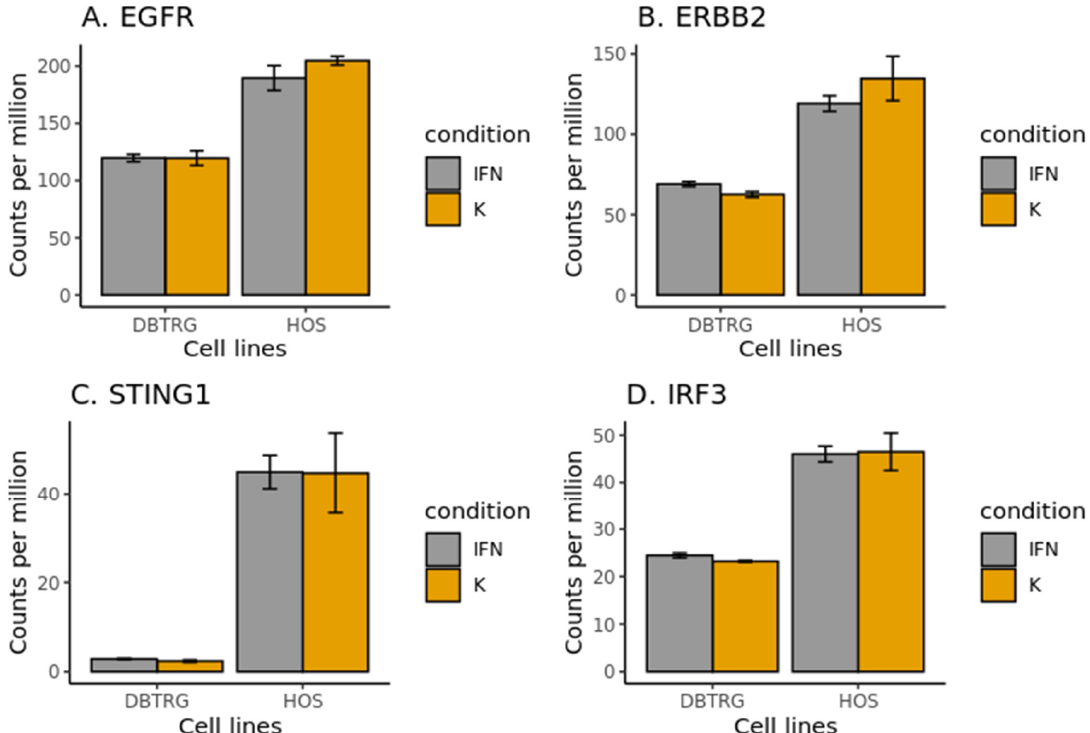
Figure 6. Expression levels of EGF receptor genes of interest and genes involved in type I interferon- inducing pathway inhibited by HER2, in DBTRG-05MG and HOS cell lines, before and after interferon α 2 β treatment, as determined by RNA-seq. Expression levels of the main EGF receptor genes, EGFR ( A ); expression levels of ERBB2 encoding HER2 co-receptor ( B ); expression levels of STING1 encoding a major sensor of cytoplasmic DNA and an inductor of type I interferon production, which HER2 inactivates through Akt1 kinase [31] ( C ); expression levels of IRF3 encoding a transcription factor that induces expression of type I interferon genes and lies downstream of STING in the pathway ( D ).